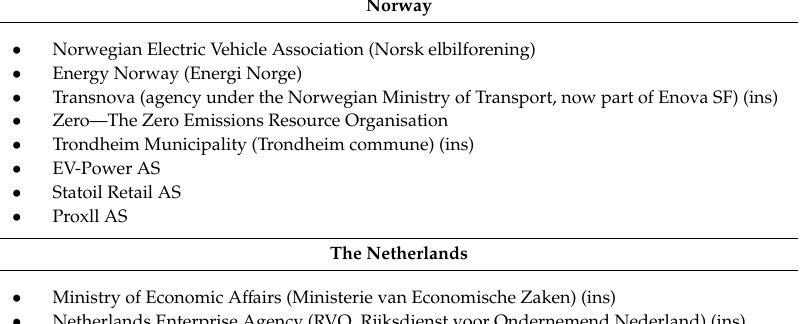
Table 1. List of stakeholder interviewees. All experts also joined the round tables within the particular country, unless indicated with an asterisk. Stakeholders we see as ‘policy insiders’ are indicated by